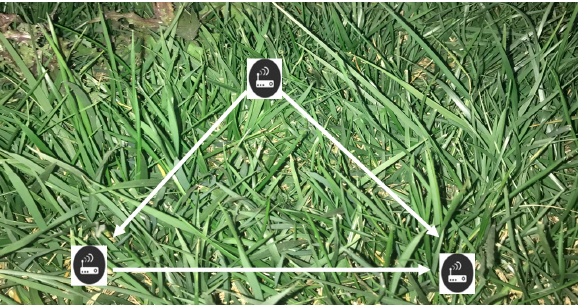
Figure 4. The uses of WSNs in precision agriculture [32].